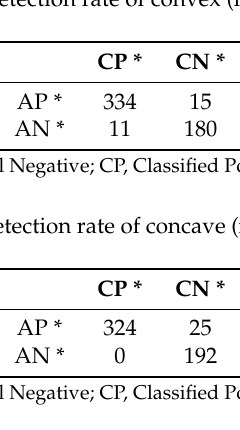
Figure 11. Experimental scene during nighttime.